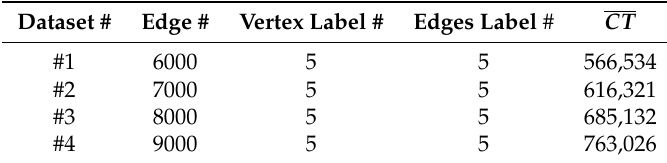
Table 3. Experimental results on the increasing number of edges.